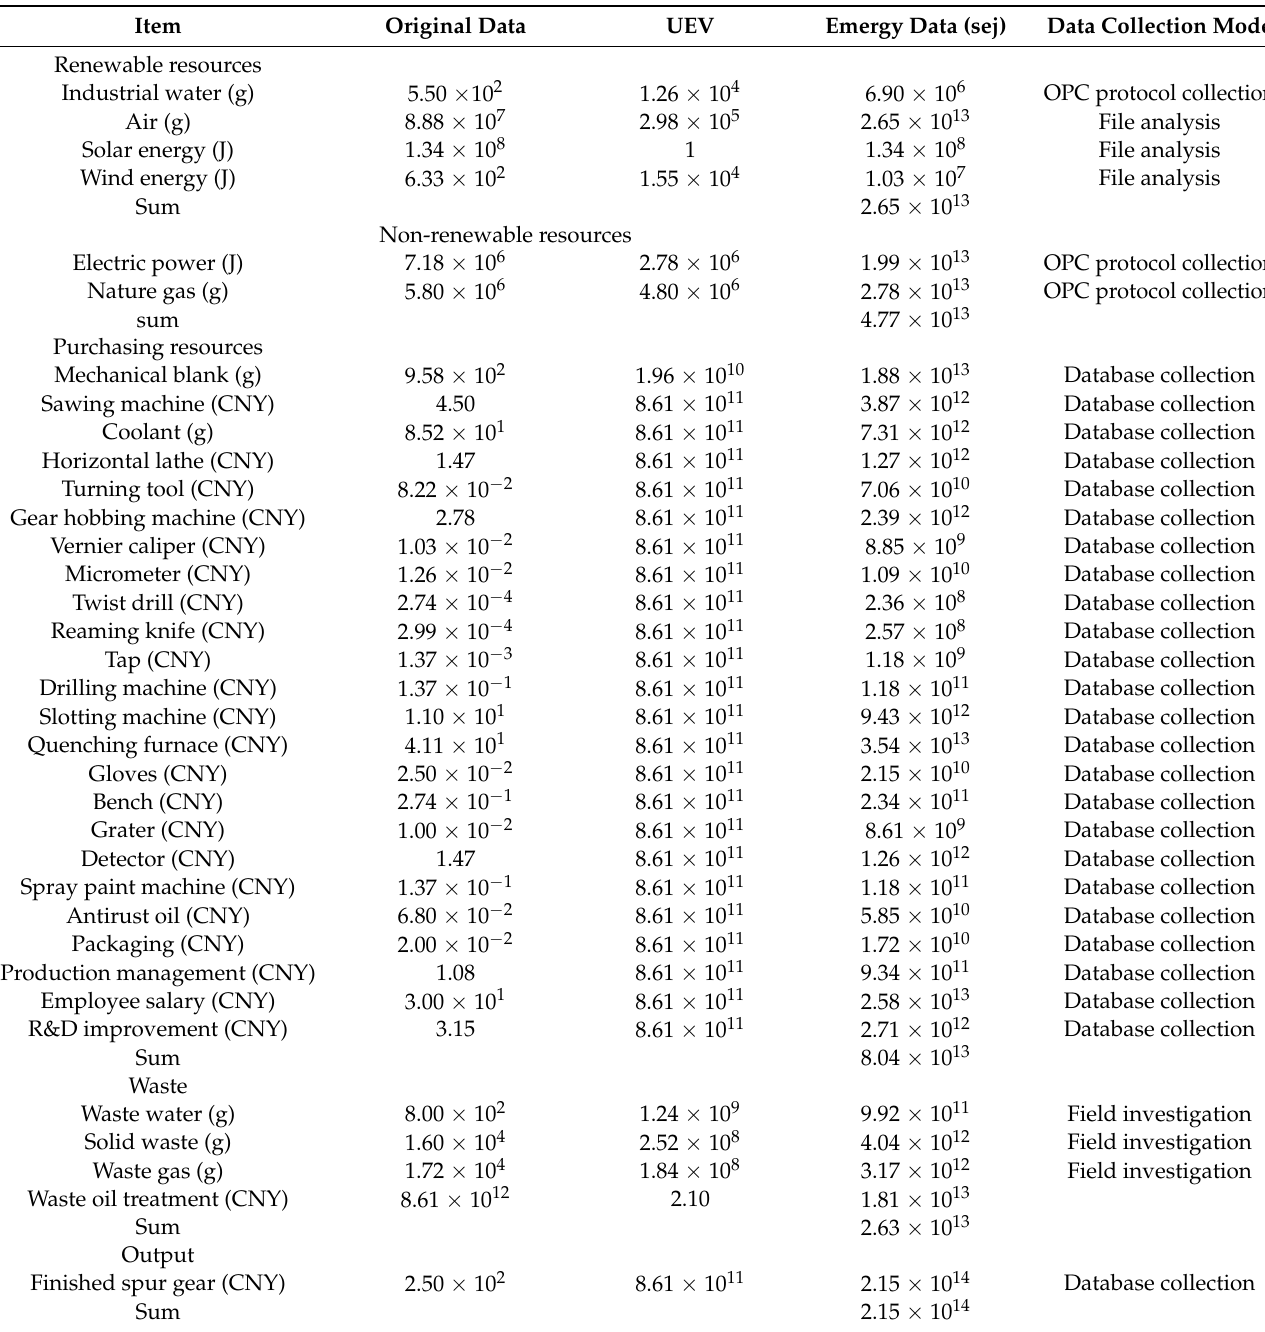
Table 2. Emergy analysis of spur gear production